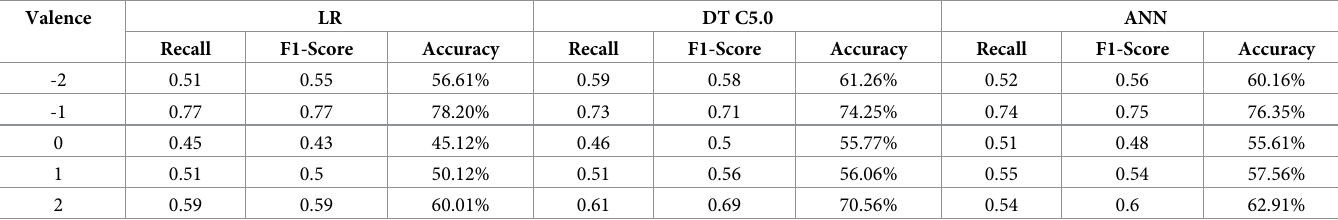
Table 11. Performance indexes of each class classification in the quinary classification model with three single classifiers.